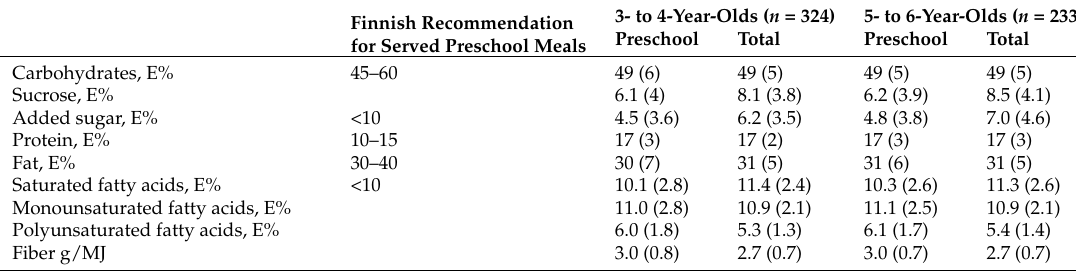
Table 6. Energy-yielding nutrient intakes [mean, (SD)] during preschool hours and the whole day (Monday to Friday) of children who eat three meals at preschool. 3- to 4-Year-Olds ( n = Finnish Recommendation for Served Preschool Meals